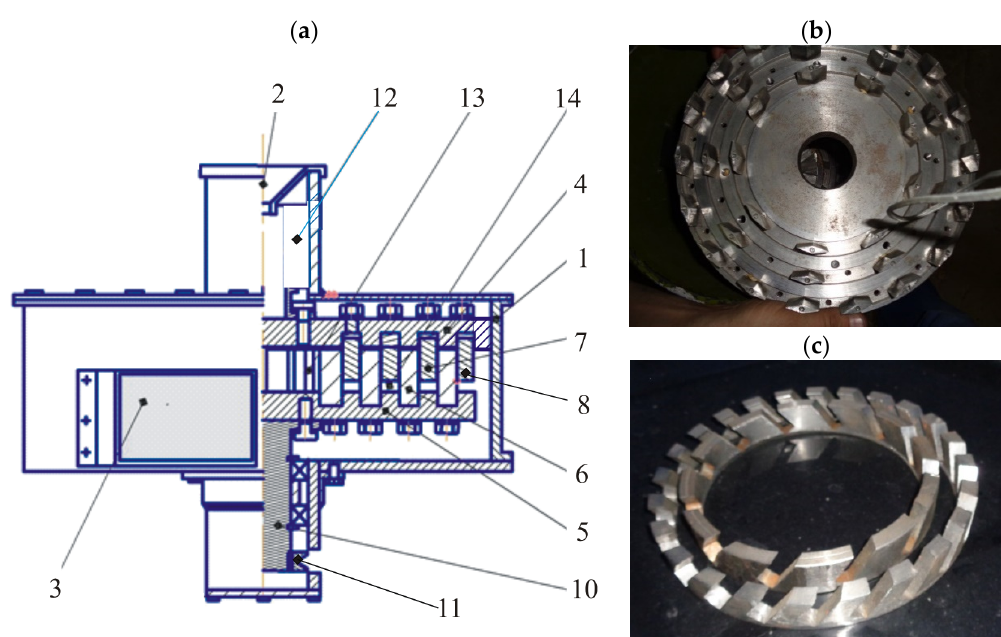
Figure 4. Design and technological scheme of a rotary-centrifugal type grain shredder ( a ): 1—housing, 2—loading pipe, 3—output pipes, 4—upper disks, 5—lower disks, 6—projections of the lower disk, 7—blades of the upper disk, 8—outer row knives, 9—grooves of the lower disk, 10—drive shaft, 11—pulley, 12—receiving chamber, 13—radial windows, 14—working chamber, rings with countersinks ( b ) and a lower disk with knives ( c ) (own study).